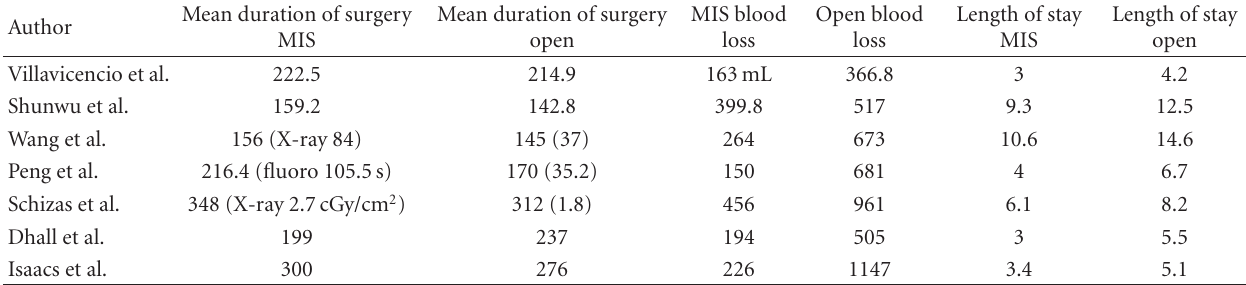
Table 2: Comparative studies basic data.